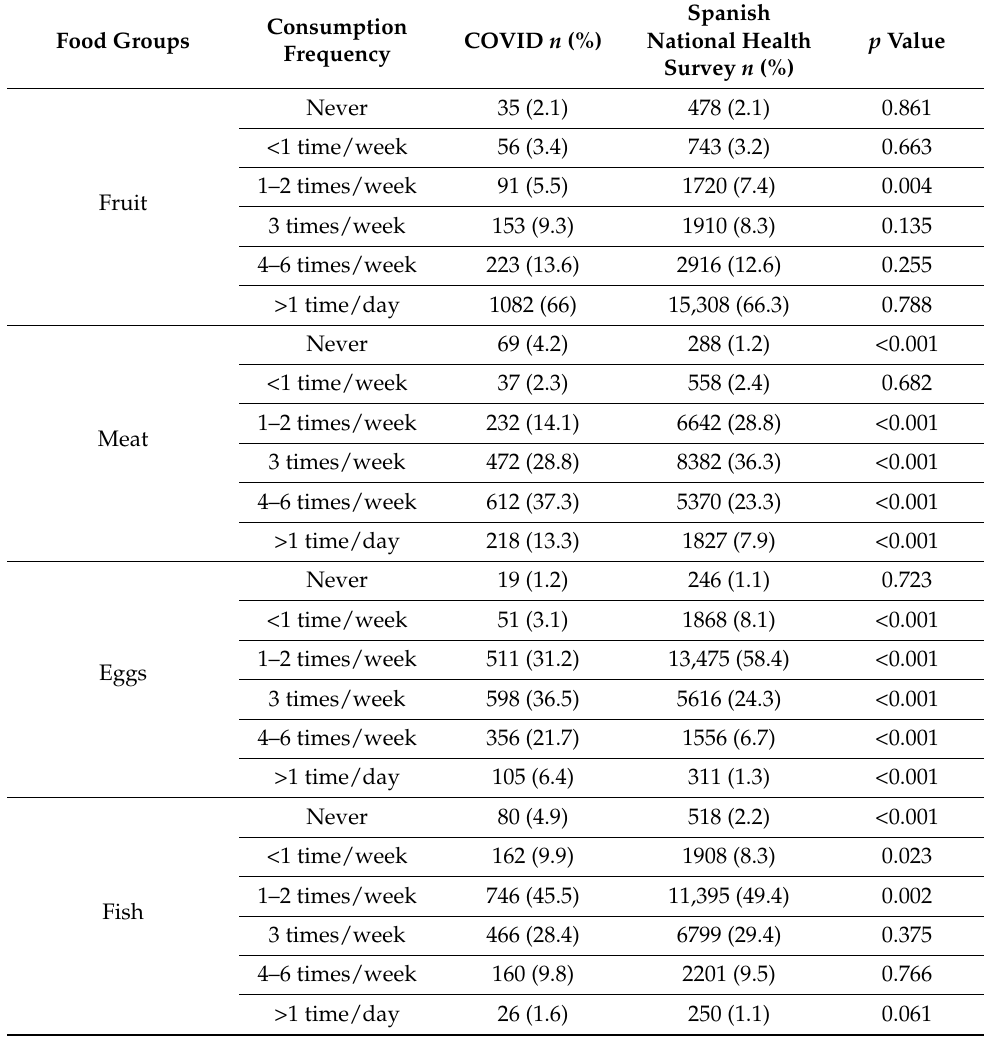
Table 4. Contrast of proportions of the consumption frequencies during confinement and according to the last Spanish national health